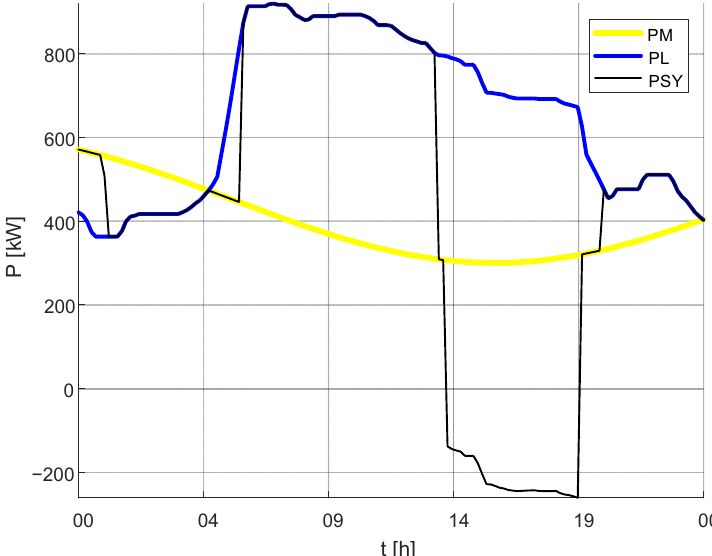
Figure 19. Results of the simulation of the operation of the private network with the BESS with real characteristics for the set exchange power according to the curve, variable in the range PM 300–600 kW; PSY—exchange power with the distribution grid and PL—load.